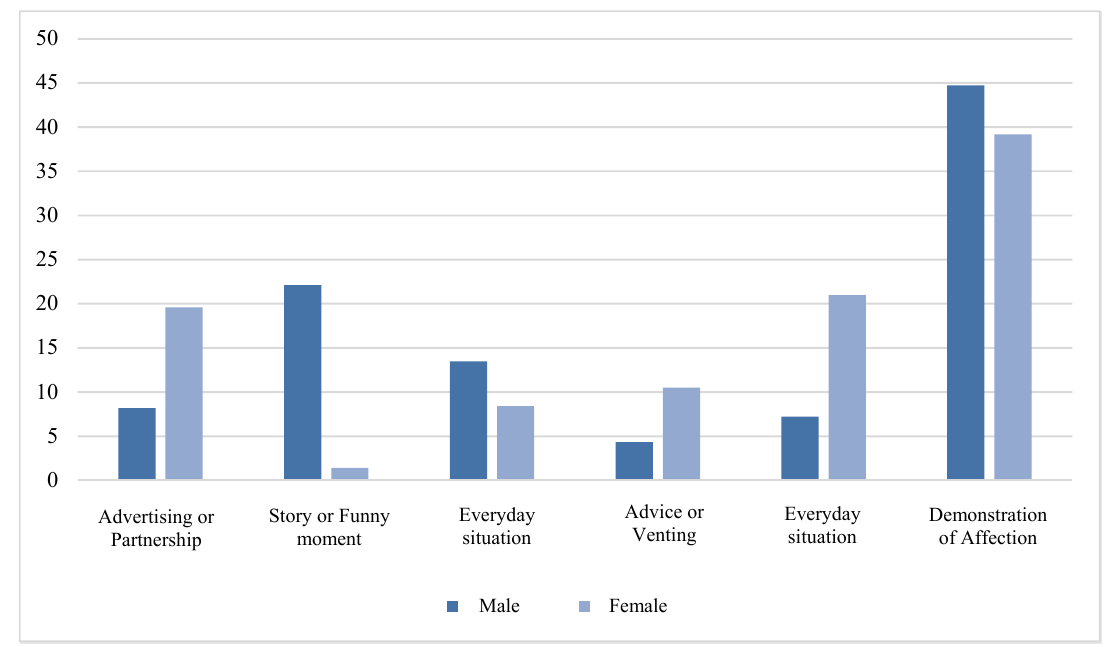
Figure 8. Nature of speech content or description of posts, IGTV and Reels by gender, %.